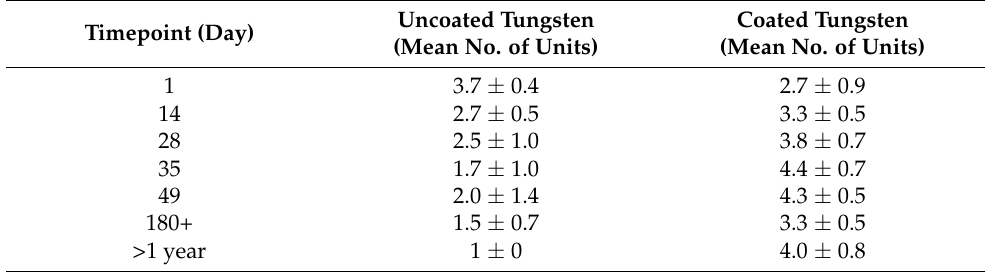
Figure 11. ( A ) Representative examples of single unit waveforms isolated from chronic neural recordings of spontaneous neural activity using tungsten microelectrodes from 5–7 weeks to >1 year. Vertical scale bar is 20 µ V and horizontal scale bar is 1 ms. ( B ) The mean peak-to-peak amplitudes (Vpp) of the largest isolated unit recorded from spontaneous neural activity is plotted for soft-coated ( n = 9) and uncoated electrodes ( n = 6) over 5 weeks of implantation. * p < 0.05; ** p < 0.01. ( C ) Long-term trends for mean peak-to-peak amplitudes (Vpp) of the largest isolated unit recorded from spontaneous neural activity are plotted for soft-coated ( n = 4) and uncoated electrodes ( n = 2) over 1 year of implantation. Soft-coated electrodes trended toward having larger peak-to-peak amplitudes compared to uncoated controls. Table 2. Number of isolated units across implantation time for tungsten microelectrodes with uncoated and coated